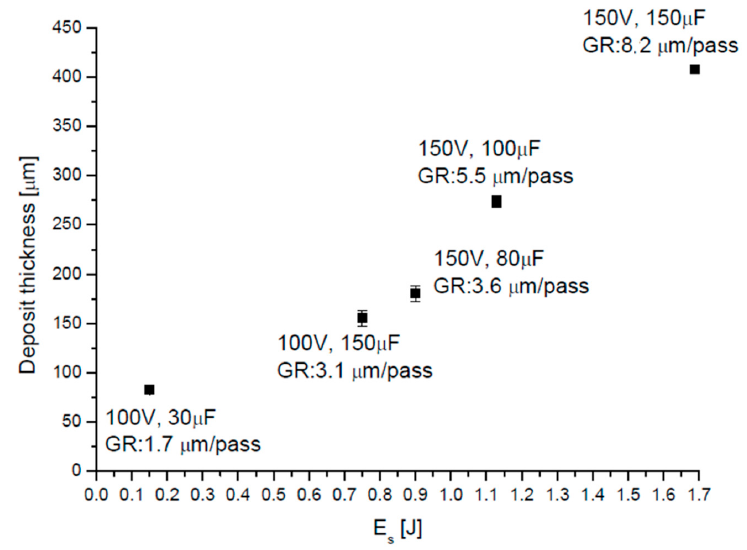
Figure 12. Energy density (E s ) vs. thickness for ESD deposits.